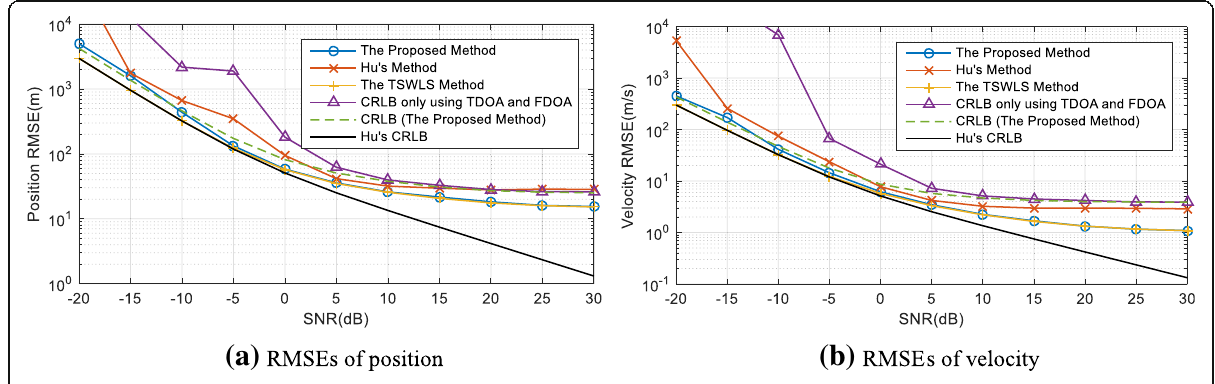
Fig. 6 RMSE comparison versus SNR when σ s = 10 0.5 m. a RMSEs of position. b RMSEs of velocity